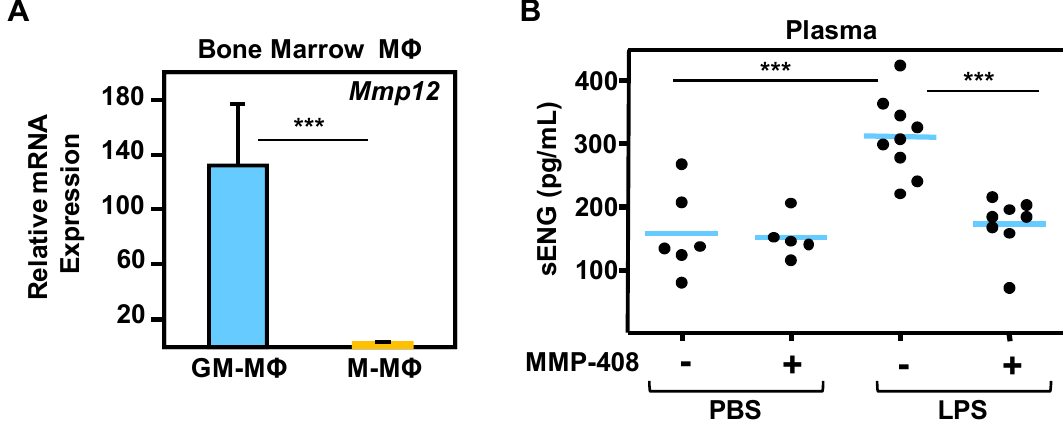
Figure 7. MMP-12-dependent release of soluble endoglin in mice. ( A ) Transcript expression levels of Mmp-12 in murine bone marrow-derived M Φ incubated with GM-CSF (GM-M Φ ) or M-CSF (M-M Φ ), as determined by qRT-PCR. Statistical significance of data ( n = 4) was calculated using a paired, two-tailed Student t test, and data are presented as mean ± SD. ( B ) Soluble endoglin levels in lipopolysaccharide (LPS)-treated animals. Mice were injected (i.p.) with LPS and orally gavaged with MMP-408 or vehicle (PBS). Plasma samples were extracted, and soluble endoglin was measured using an ELISA kit. A point cloud representation is shown where blue horizontal bars indicate the median values of each